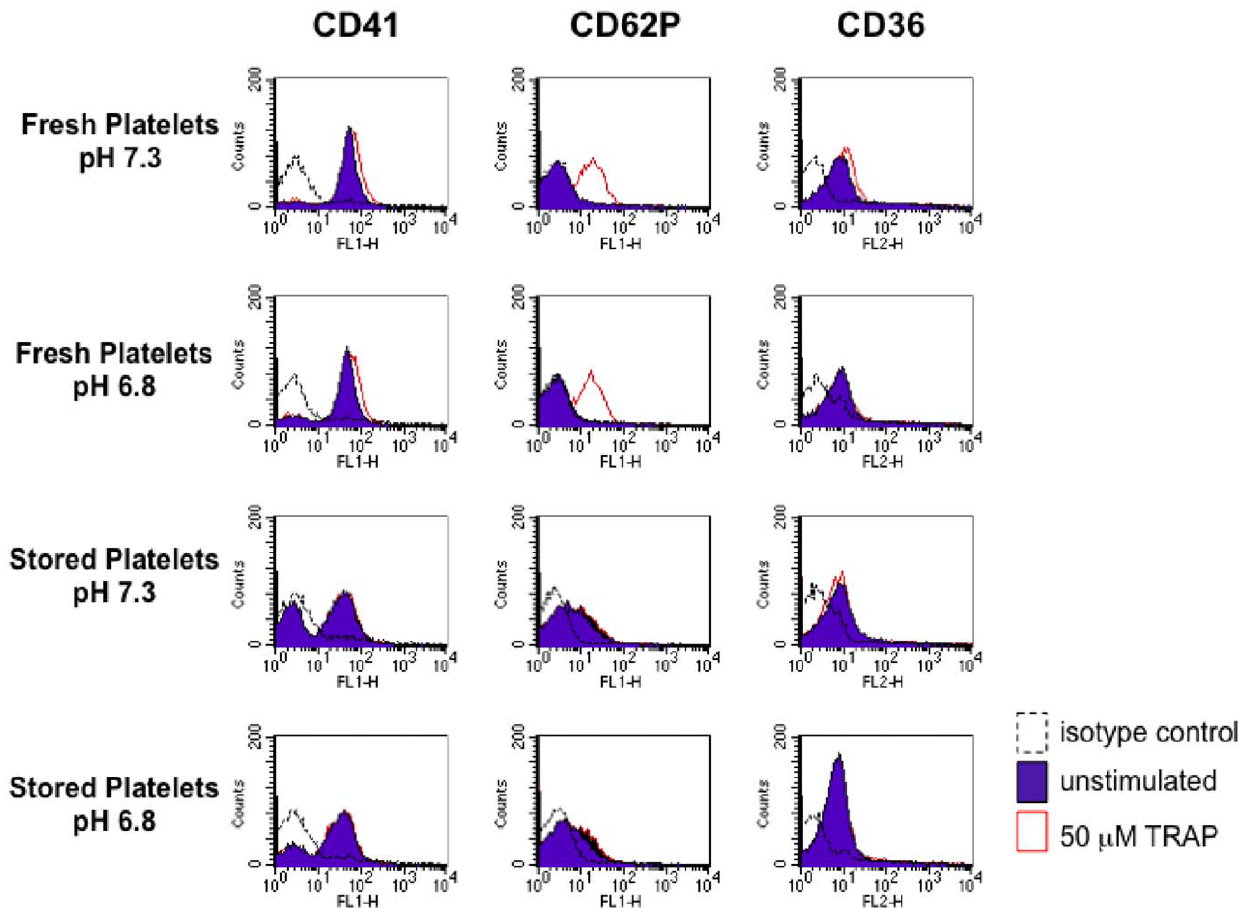
Figure 6. Platelet surface marker expression on fresh and stored platelet preparations. Platelet-rich plasma prepared from freshly drawn whole blood (‘‘fresh platelets’’) or from whole blood from the same donor stored at 4 u C for one week (‘‘stored platelets’’) was diluted in modified Tyrode’s buffer at pH 7.3 or pH 6.8 and incubated for 40 min at room temperature. Surface expression of CD41 (platelet-specific constitutive marker), CD62P (platelet activation marker), and CD36 was assessed by flow cytometry under resting conditions and on platelets stimulated with 50 m M Thrombin Receptor Activator Peptide (TRAP). Specific monoclonal antibodies (mAbs) for each receptor were used along with an isotype control mAb. Data obtained from one donor are shown, and a second independent donor showed very similar